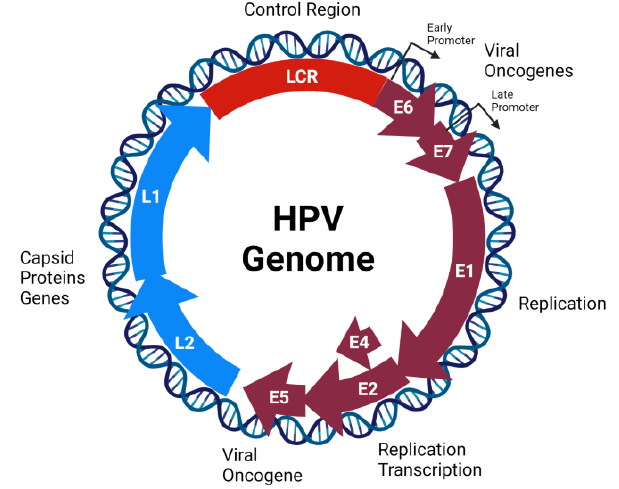
Figure 1. Human papillomavirus (HPV) genome organization. The HPV contains a circular double- stranded DNA genome with approximately 8000 base pairs (bp), organized into three regions. The E or early region (purple) contains the E1, E2, E4, E5, E6, and E7 open reading frames (ORFs). The L or late region (blue) contains the L1 and L2 ORFs. Finally, the Long Control Region (LCR) (red) contains regulatory elements.